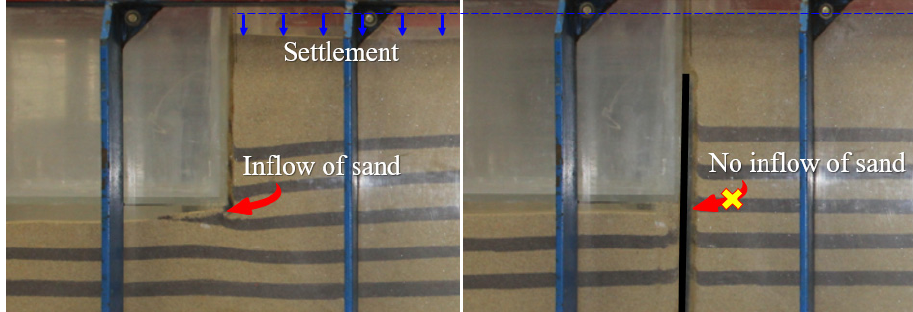
Figure 7. Soil inflow behavior: without SFP; with SFP.